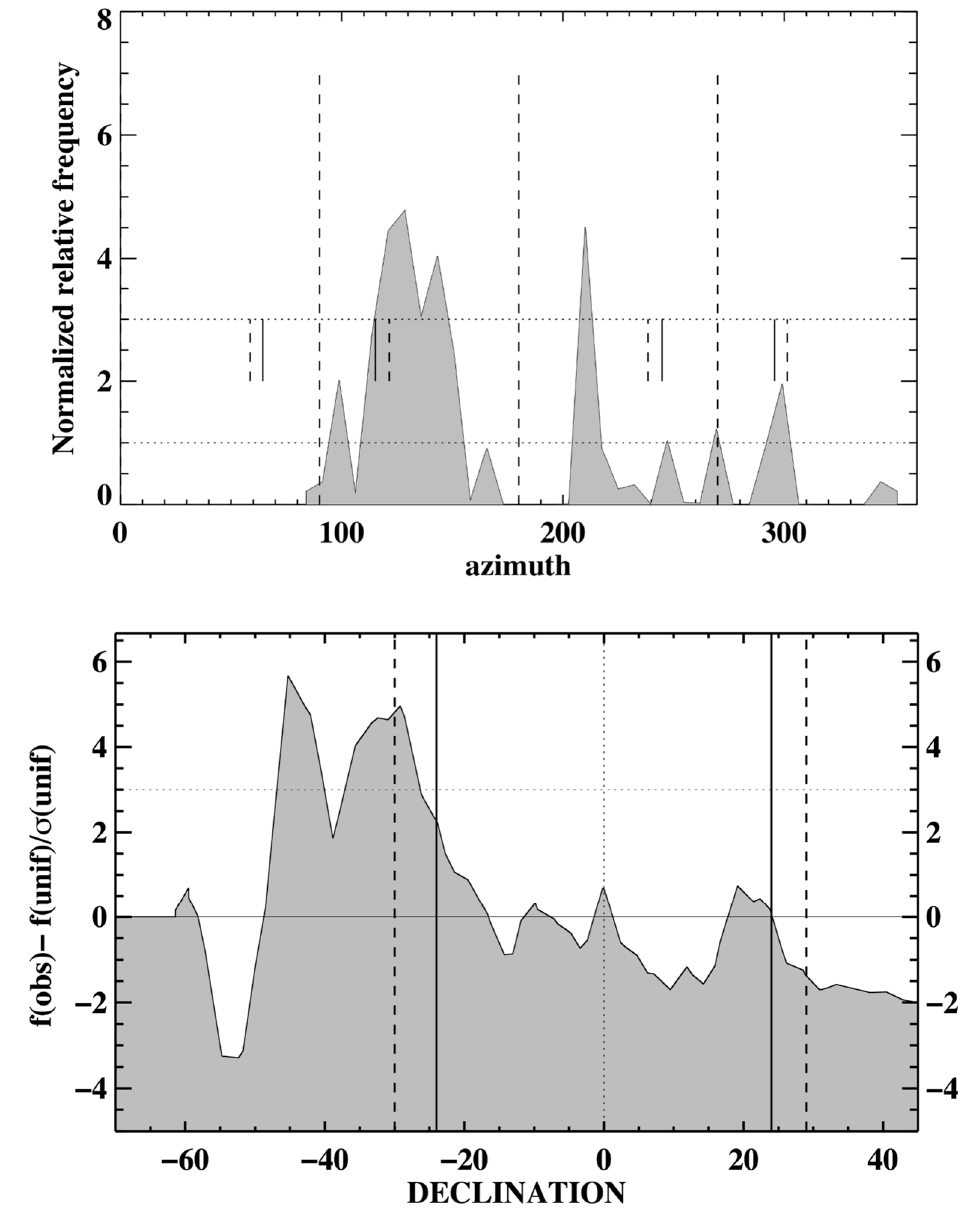
Figure 5. ( Top ), azimuth histogram. The vertical dashed lines are the cardinal directions; the short vertical solid lines indicate the solstices while the short dashed vertical lines indicate the lunar extremes. The relative frequency has been normalized by the mean, thus concentrations above a value of 3 are statistically significant. ( Bottom ), declination histogram. The vertical dotted line indicates the equinoxes, solid vertical lines the solstices, and vertical dashed lines the lunar extremes. The data are normalized as indicated in the text, thus concentrations above a value of 3 are statistically sig- ni fi cant.